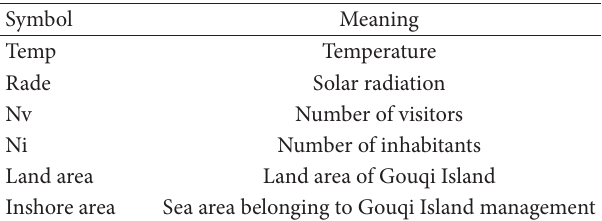
Table 3: Forcing functions of the